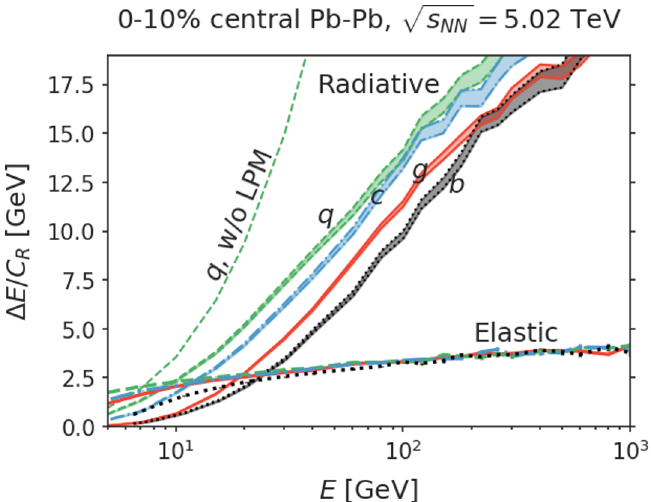
Figure 1 . Parton energy loss in 0–10% Pb-Pb collisions, scaled by the color factor C R , as a function of the initial parton energy. The parton’s initial production point is sampled from the transverse density of binary collisions. The radiative energy loss for light quark q , charm quark c , bottom quark b , and gluon g are the colored bands (statistical uncertainty) labeled in the plot. Lines corresponds to the elastic energy loss of different species of